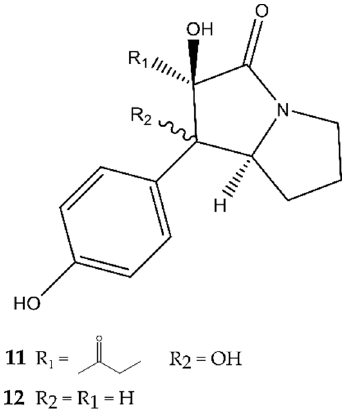
Figure 3. The antimicrobial pyrrolizidines brocapyrrozin A ( 11 ) and B ( 12 ).